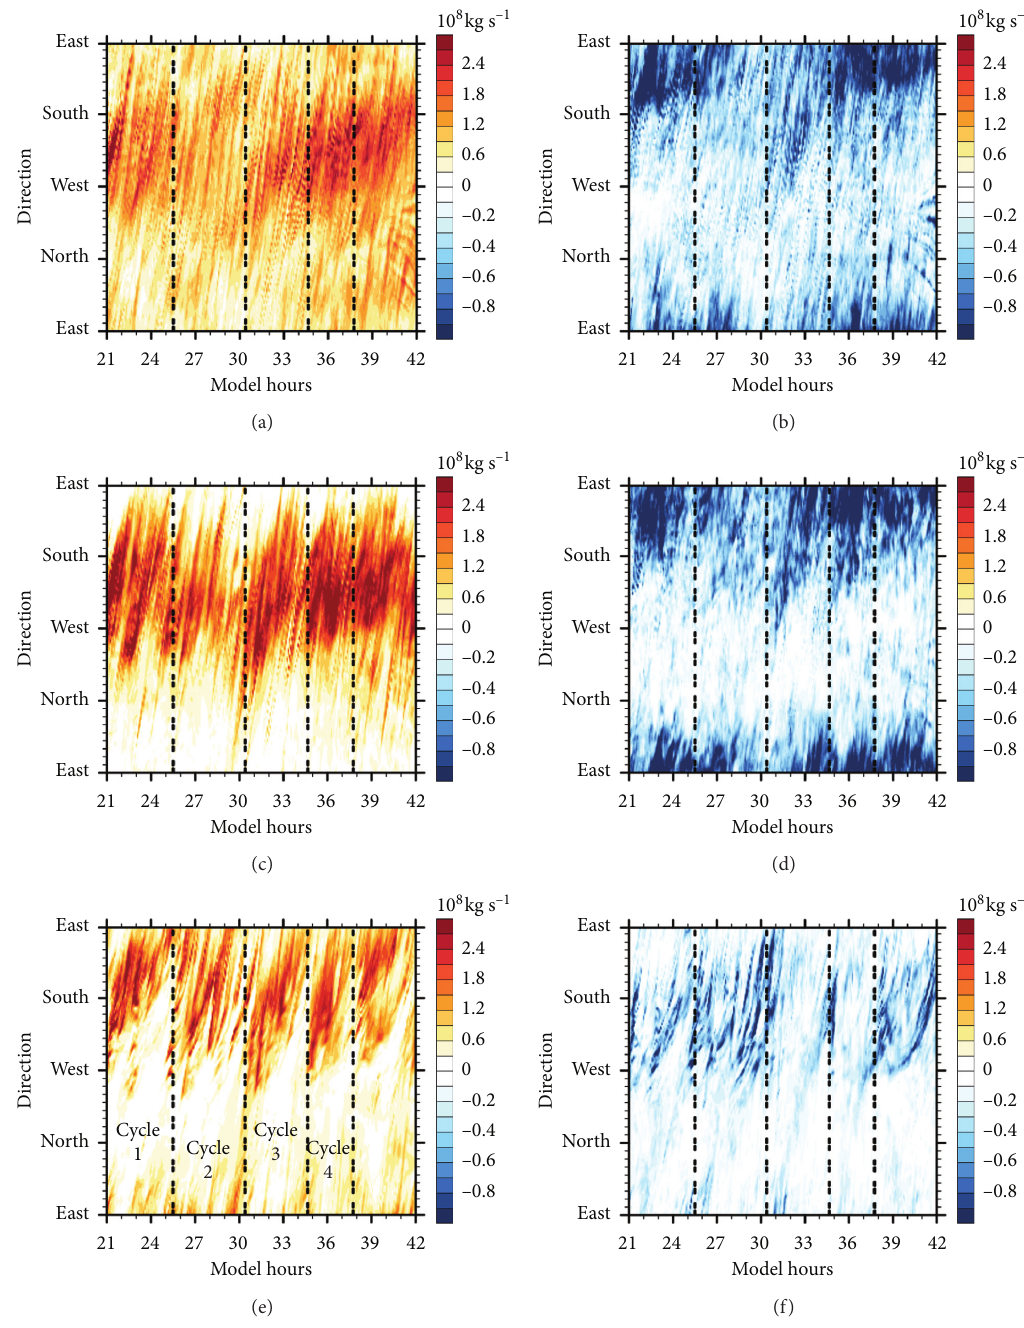
Figure 10: Time-azimuth diagram of upward mass flux at a radius of 20–80km at heights of (a) 1.3km, (c) 5.6km, and (e) 12.7km. In each panel, the four periodic cycles are separated by black dashed lines. (b, d, f) They are the same as (a), (c), and (e) but for downward mass